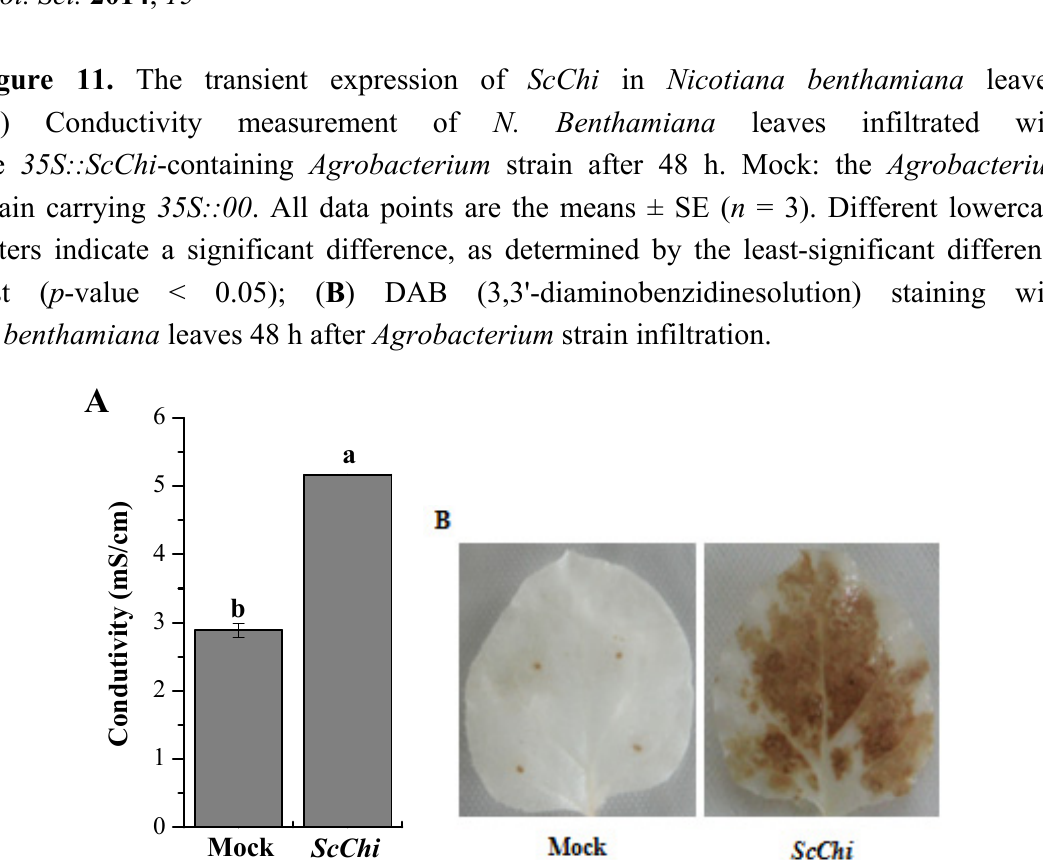
Figure 12. RT-qPCR analysis of ScChi and the immunity related marker genes in the Nicotiana benthamiana leaves 24 h after transiently expressing pCAMBIA 1301- ScChi and the empty vector. ( A ) The transcript analysis of ScChi ; ( B ) the transcript analysis of the immunity related marker genes, including the hypersensitive response marker genes, NtHSR201 , NtHSR203 and NtHSR515 , the salicylic acid related gene, NtNPR1 , the jasmonate associated genes, NtPR-1a/c , NtPR2 and NtPR3 , and the ethylene synthesis depended genes, NtEFE26 and NtAccdeaminase. NtEF1- α was used to normalize the transcript levels. Mock: the Agrobacterium strain carrying 35S::00 . All data points are the means ± SE ( n = 3). Different lowercase letters indicate a significant difference, as determined by the least-significant difference test ( p -value <